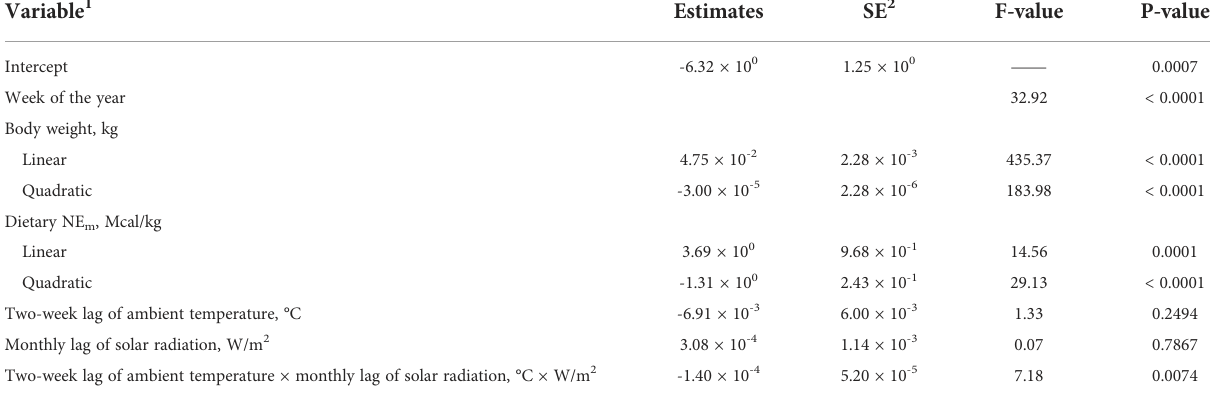
TABLE 8 Base model, two-week lag of ambient temperature and monthly lag of solar radiation and their interaction. Variable